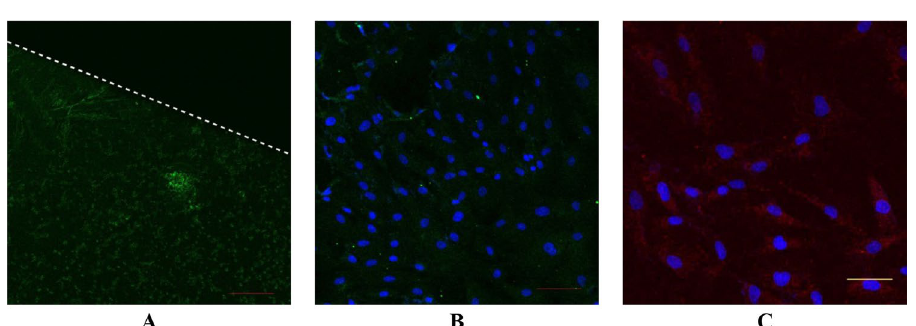
Figure 7. Immunocytochemistry (ICC) of RGD from spidroin micropattern without cell ( A ), with cell ( B ) and ICC of Integrin β1 from hWJ-MSC grown on spidroin micropattern ( C ). RGD appeared green, integrin β1 appeared red, and the nucleus appeared blue on images. Scale bar = 50 µm, white dashed line separated the spidroin micropattern (lower part) and non-patterned area (upper